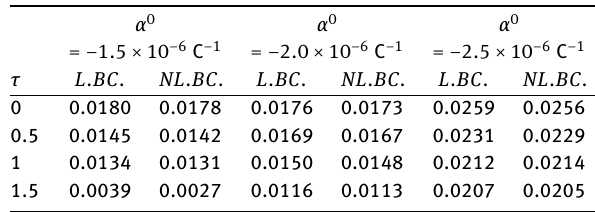
Table 5: Natural frequency (THz) of a CNT in both local and nonlocal